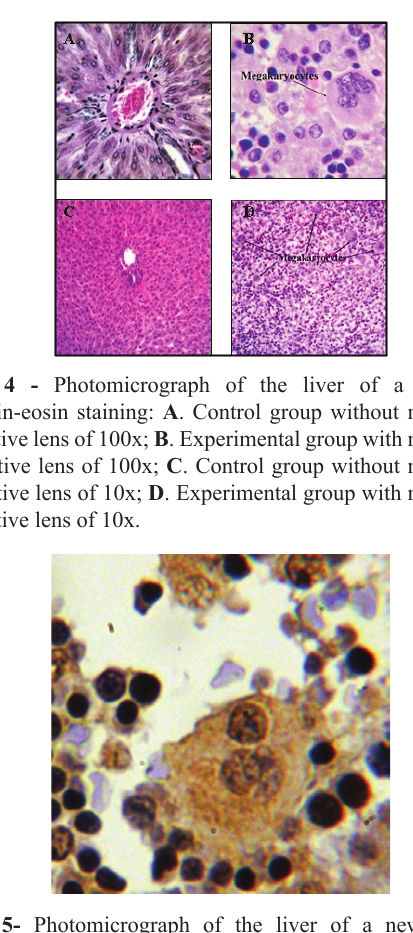
FIGURE 3 – Correlation coefficients between fetal hydrops and hematopoiesis and between newborn weight and hematopoiesis. Pearson’s correlation test was done for each column, and it was observed that both correlation coefficients were significant (p-value of 90% for the correlation between hydrops and hematopoiesis and 85% for the correlation between weight and hematopoiesis).